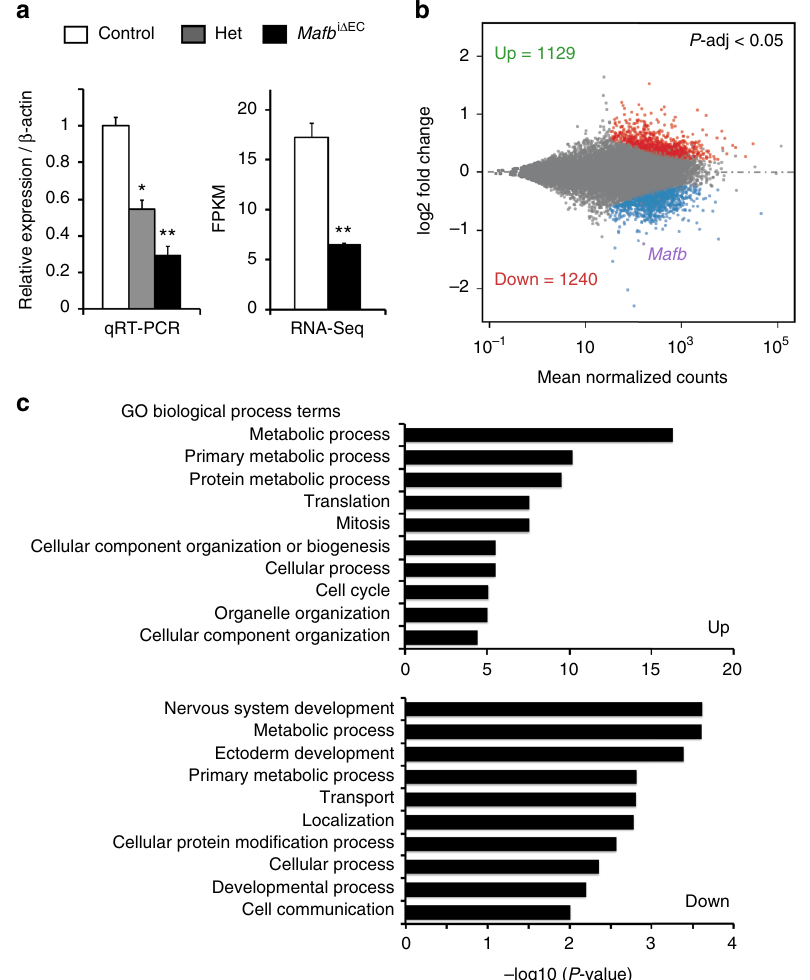
Fig. 5 RiboTag/RNA-Seq analysis of EC-speci fi c Mafb mutant mice. a Mafb expression in P6 control, Mafb heterozygous mutant ( Pdgfb-iCre Mafb + /p ; Het) or Mafb i Δ EC retinal ECs assessed by RT-qPCR or RNA-Seq. n = 3, Error bars represent mean + s.e.m. * P < 0.05, ** P < 0.001; unpaired Student ’ s t- test. b MA plot of DEGs between P6 Mafb i Δ EC ECs and control retinal ECs. n = 3, red dots , upregulated genes (1129); blue dots , downregulated genes (1240); purple dot , Mafb . c Top GO biological process terms enriched in up- or downregulated genes in Mafb mutant retinal ECs at